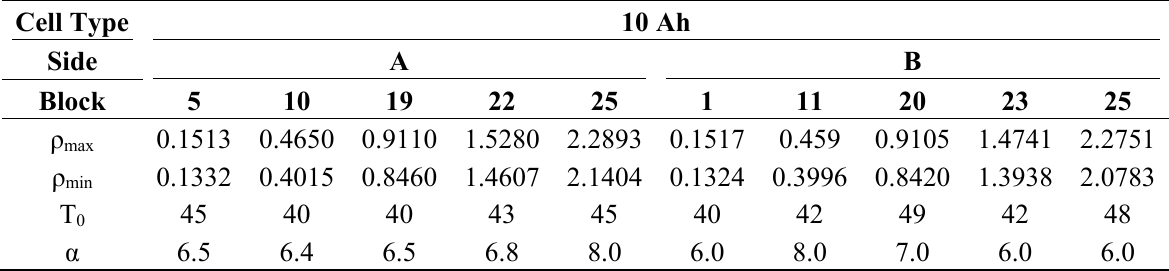
Table 3. Fitted parameters of representative blocks of sides A and B on 10 Ah cell.